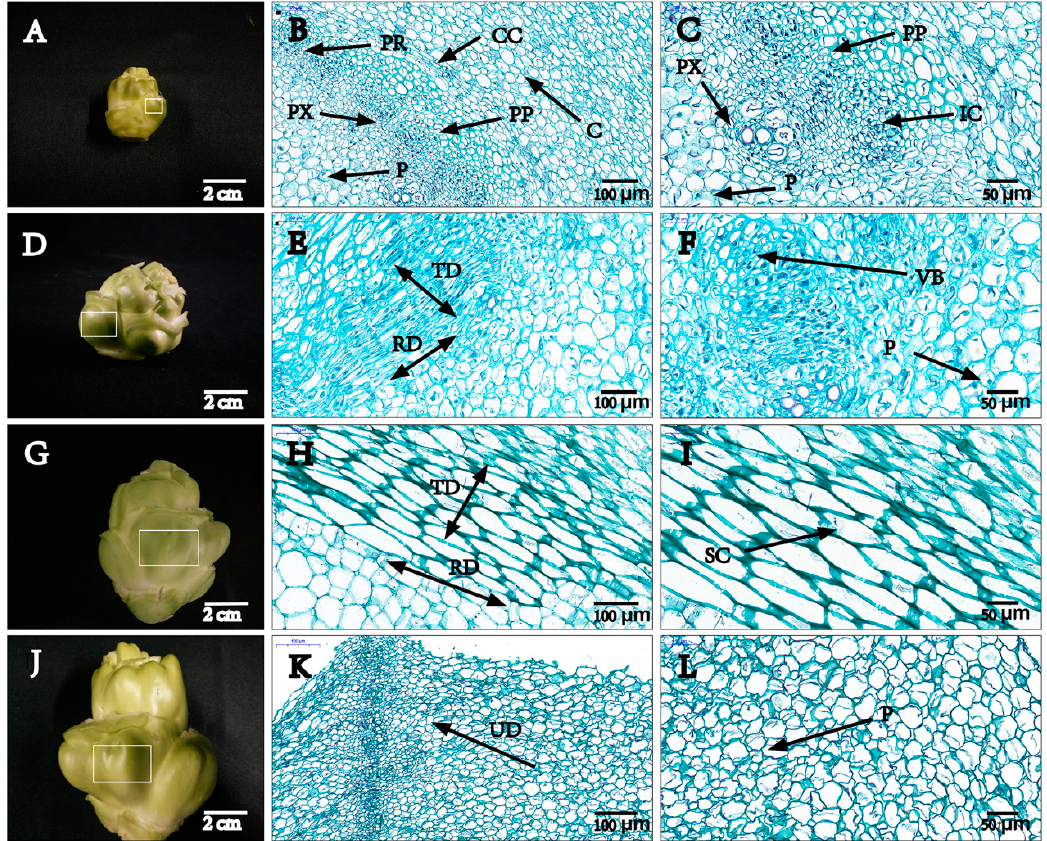
Figure 1. Stem anatomy at four different developmental stages (S1, S2, S3, S4). Scale bars: 2 cm ( A , D , G , J ); 100 µ m ( B , E , H , K ); 50 µ m ( C , F , I , L ). The transverse diameters are 2 cm in (A–C) (S1); 4 cm in (D–F) (S2); 6 cm in (G–I) (S3) and 8 cm in (J–L) (S4), respectively. I indicates tangential division cell layer, K indicates non-directional cell division area in the cortex and L indicates cell expansion. CC: